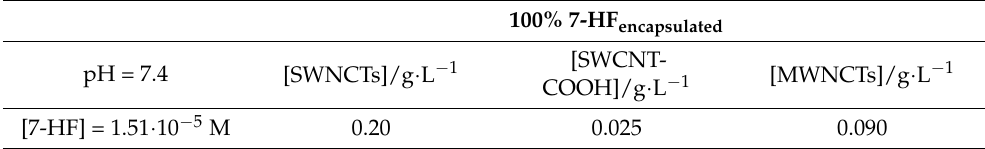
Table 1. CNT concentration necessary to completely encapsulate the 7-HF at pH = 7.4.